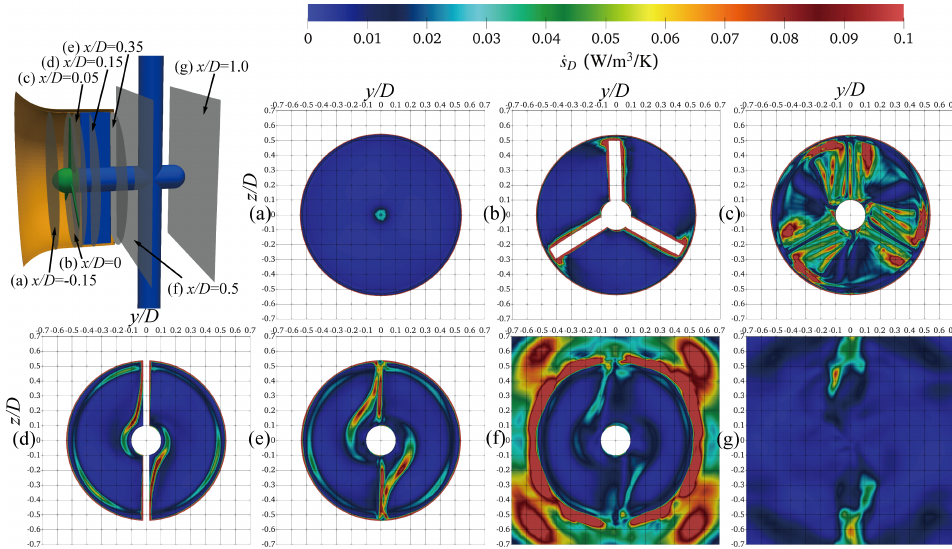
Figure 9. ˙ s D distribution of the turbine at different longitudinal positions ( TSR = 3.6 )